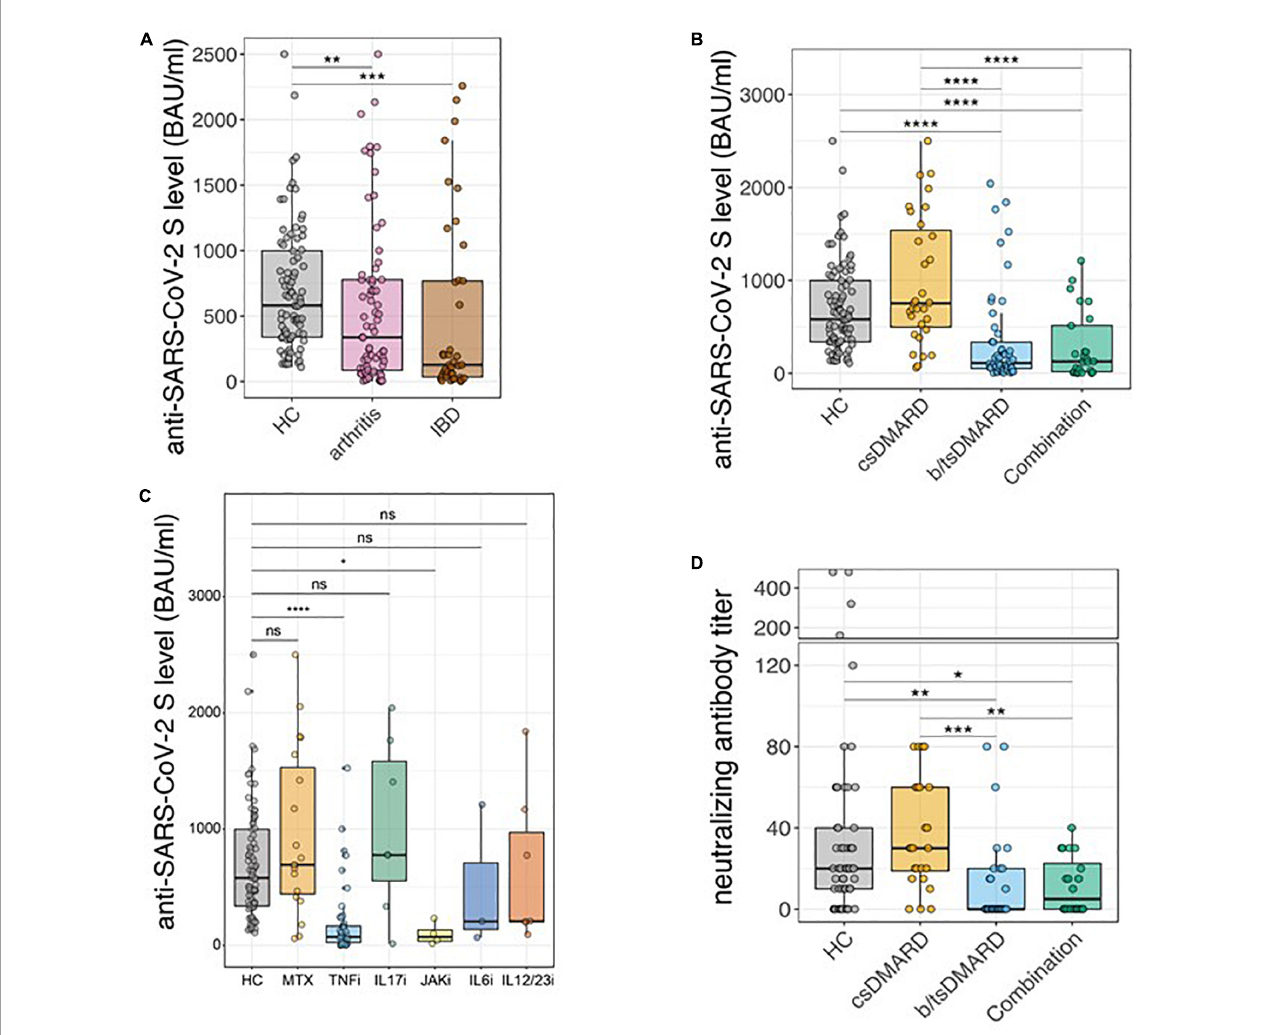
FIGURE1 (A) Analysis of anti-SARS-CoV-2 S titers 6 months after the first two vaccination doses in HC ( n = 85) and patients with inflammatory arthritis ( n = 75) and inflammatory bowel disease ( n = 41). (B) Analysis of anti-SARS-CoV-2 S titers 6 months after the first two vaccination doses comparing different treatment classes HC ( n = 85), csDMARD ( n = 30), b/tsDMARD ( n = 54), and a combination of csDMARD and b/tsDMARD ( n = 28). (C) Anti-SARS-CoV-2 S titers 6 months after the first two vaccination doses in patients with IBD and inflammatory arthritis according to the specific immunomodulatory treatments. HC ( n = 85), methotrexate monotherapy (MTX mono; n = 19), tumor necrosis alpha-inhibitors (TNFi; n = 48), interleukin-17 inhibitors (IL-17i; n = 7), Janus kinase inhibitor (JAKi; n = 4), interleukin-6 receptor inhibitors (IL-6Ri; n = 3), interleukine-12/23 inhibitor (IL-12/23i n = 7). (D) Determination of neutralizing antibody activity in sera of HC ( n = 56) and patients with inflammatory arthritis ( n = 75) receiving the indicated therapies. Statistics used: Kruskal–Wallis test and subsequent Dunn’s test, adjusting for multiple testing using the Benjamini–Hochberg method. ns: non significant p > 0.05; * p ≤ 0.05; ** p ≤ 0.01; *** p ≤ 0.005; and **** p ≤ 0.001.